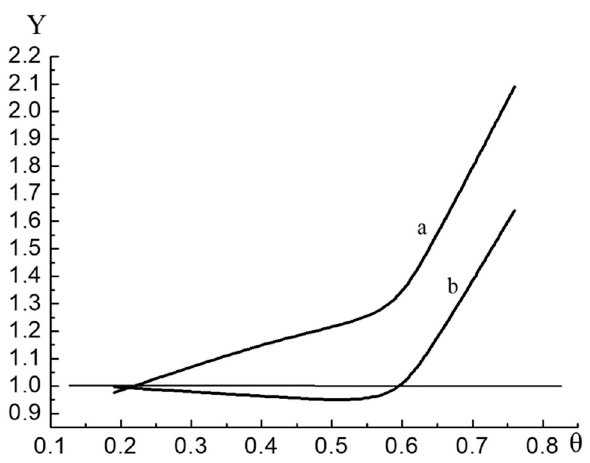
Figure 2. Results of analysis for sample № 1 with Formula (33). (a) Equation (27); (b) Equation (31).